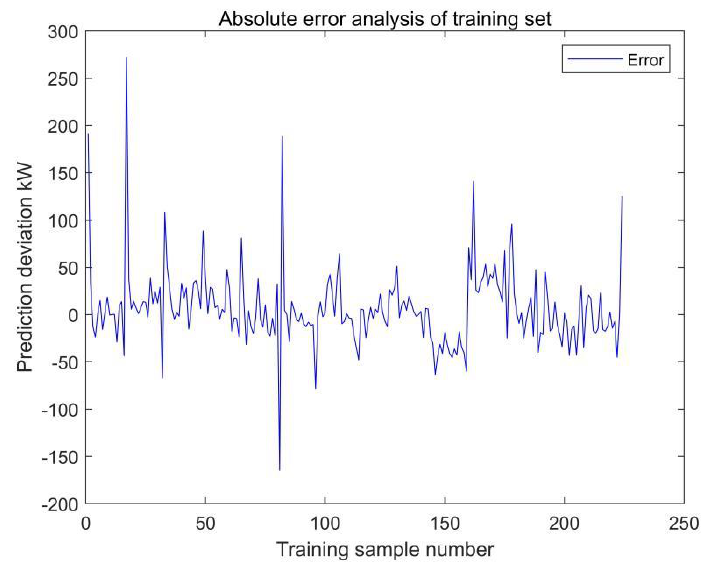
Figure 32. The absolute error plot of the training set.